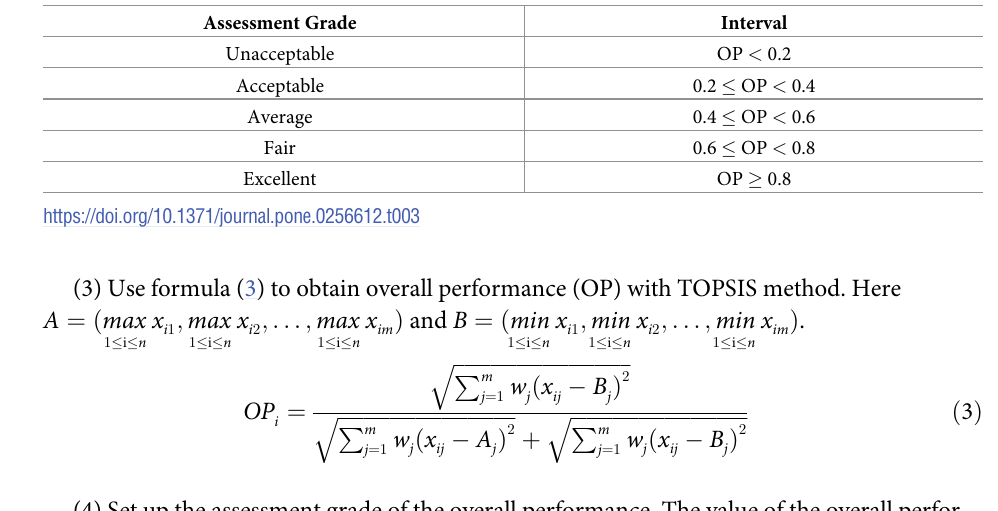
Table 3. Assessment grade of the overall performance.